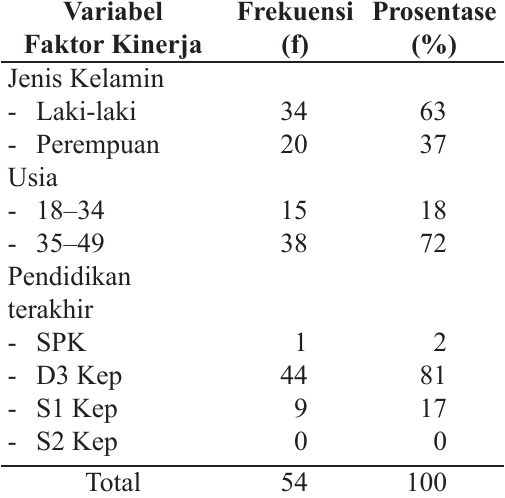
Tabel 1. Karakteristik Perawat IGD